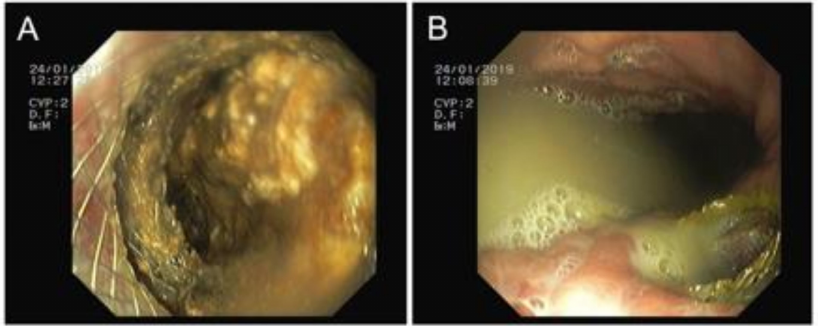
Figure 3. Transmural route. ( A ) Necrosectomy through the prosthesis and ( B ) purulent drainage to the gastric lumen.